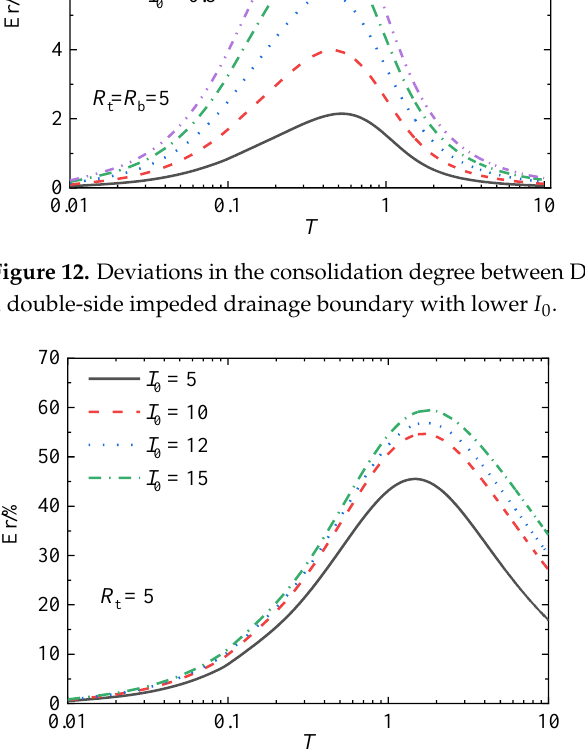
Figure 13. Deviations in the consolidation degree between Darcy’s law and non -Darcian flow under a double-side impeded drainage boundary with larger I 0 .